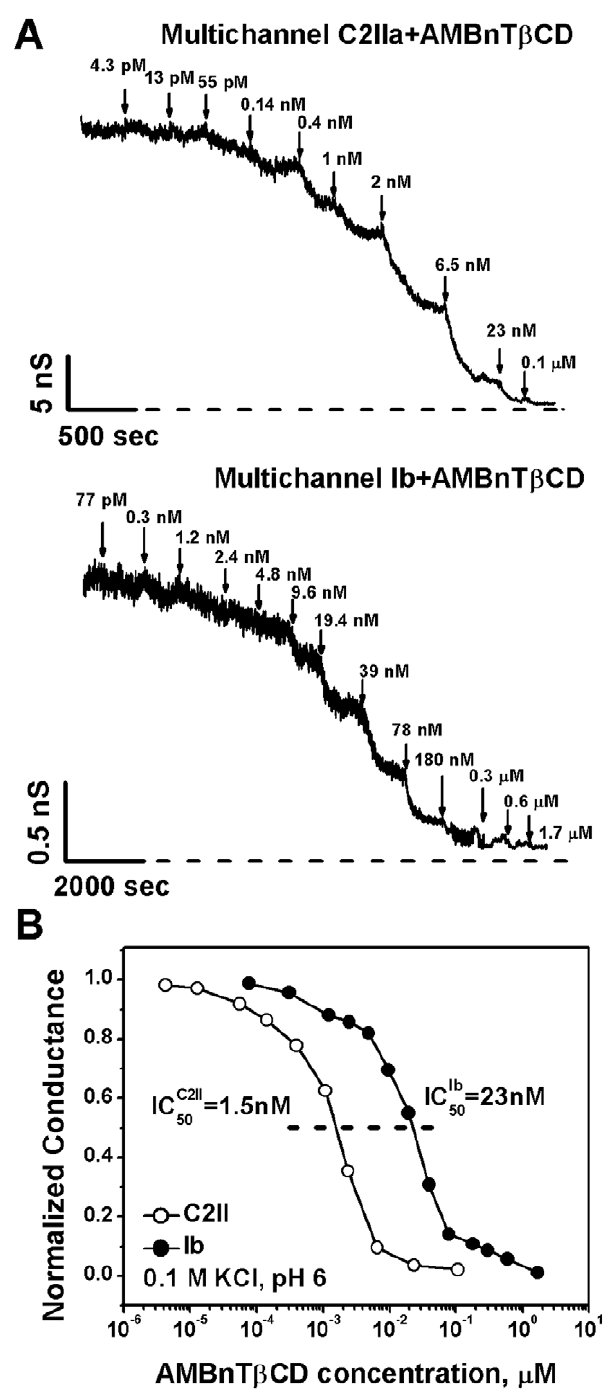
Figure 8. AMBnTßCD blocks the transmembrane pores formed by C2IIa and Ib in planar lipid membranes at the multichannel level. A . Multichannel C2II (top) and Ib (bottom)-induced conductance changed by AMBnTßCD addition. The current recordings were additionally filtered over 500-ms time interval. 0.1 M KCl solutions at pH 6 were buffered by MES. Recordings were taken at 20 mV applied voltage. B . Typical multichannel titration curves for C2IIa (left) and Ib (right)-modified membranes show about 15 times lower IC 50 values for C2II channels. All multichannel measurements were taken at 20 mV applied